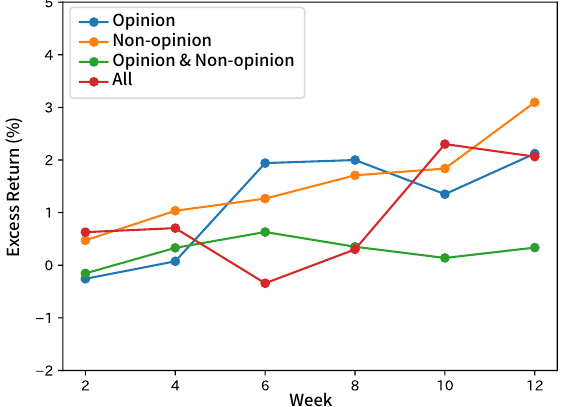
Figure 12. Excess returns of Broker D in forecasting excess returns.